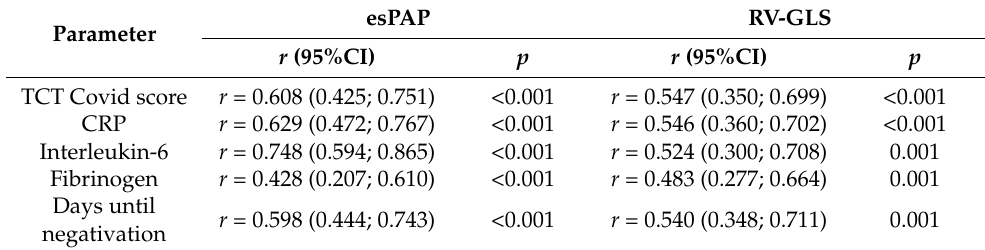
Table 2. Relationship between esPAP and RV-GLS and the studied